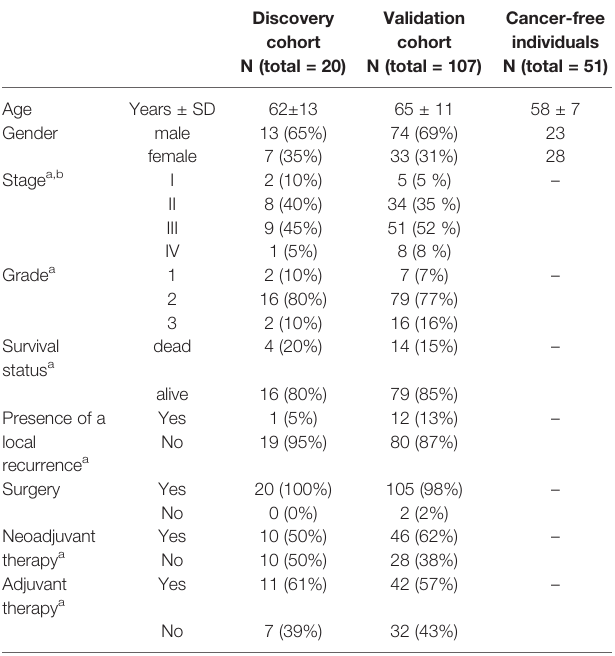
TABLE 1 | Patient ’ s clinical